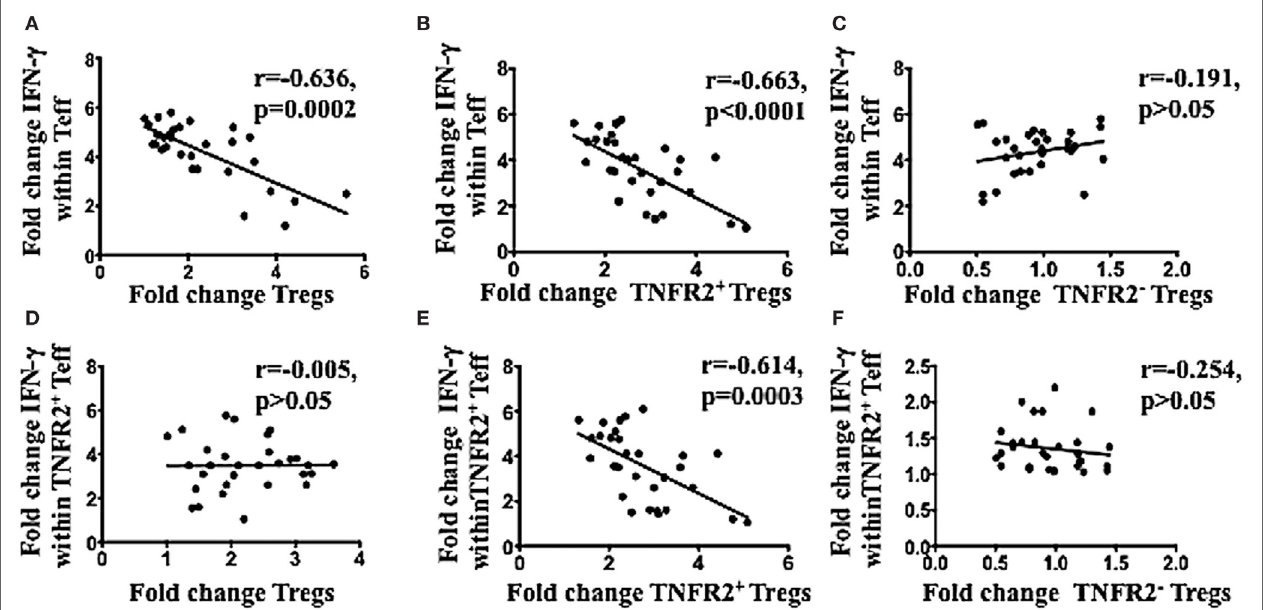
FigUre 4 | TNFR2 + regulatory T cells (Tregs) conditioned in ascites, compared to media had a higher frequency and were inversely correlated with IFN- γ production by effector T cells in the same donor. Peripheral blood mononuclear cells from healthy donors from three independent experiments ( n = 30) were incubated in either AIM V media or ascites supernatant of an advanced epithelial ovarian cancer patient for 48 h in two plates simultaneously. One of plate was left unstimulated for quantification of T cell subsets, while another plate was incubated with PMA and ionomycin for the last 6 h, and Brefeldin A was added at 1 μ g/ml for the last 5 h of incubation, to detect intracellular cytokine production. Cells were washed, labeled for surface markers CD3, CD4, CD25. Tumor necrosis factor receptor 2 (TNFR2) followed by intracellular staining for FoxP3 and IFN-gamma (IFN- γ ) and then prepared for flow cytometric analysis. (a–c) Correlation of the fold change in Tregs (a) . TNFR2 + Tregs (B) , and TNFR2 – Tregs (c) , following conditioning in ascites with the fold change in IFN- γ production by T effector (Teff) respectively. (D–F) Correlation of the fold change in Tregs (D) , TNFR2 + Tregs (e) , and TNFR2 – Tregs (F) conditioned in ascites with the fold change in IFN- γ production by TNFR2 + Teff respectively. p > 0.05 is not